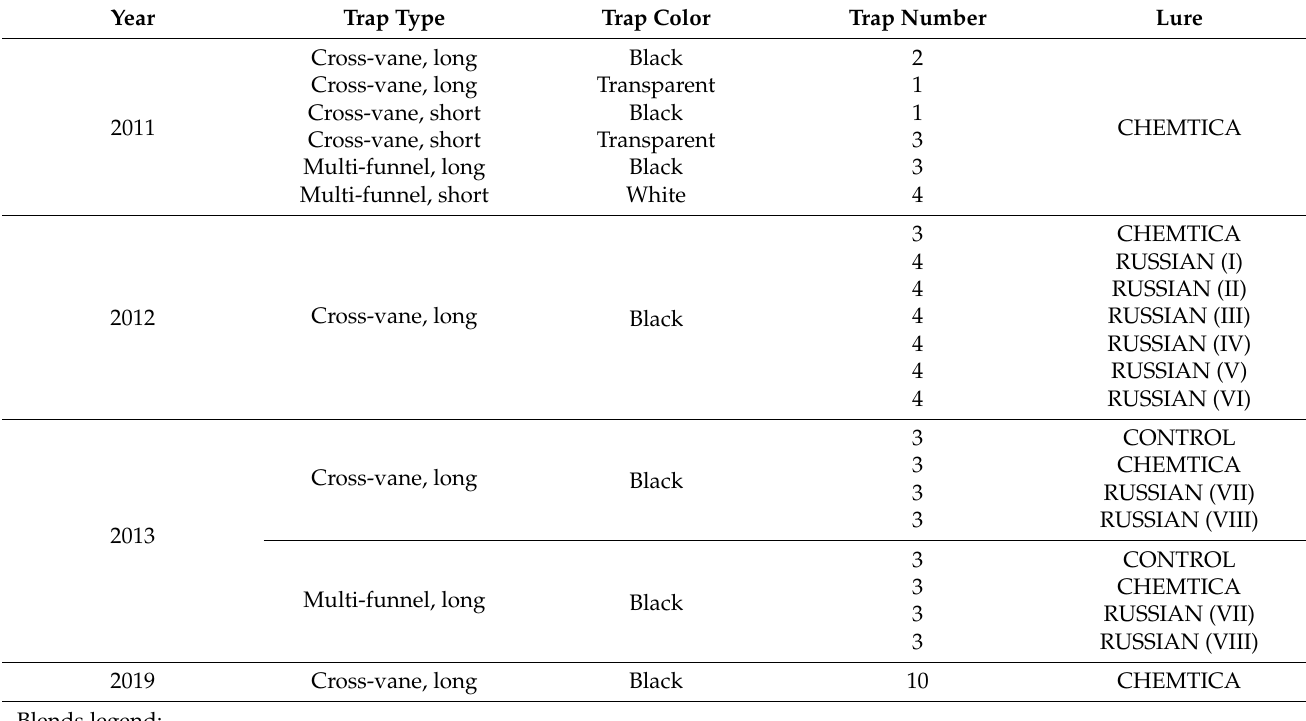
Table 1. Information about detection tools used during the eradication program. For each year information was reported about the trap model (type and color), the trap number, and the type of